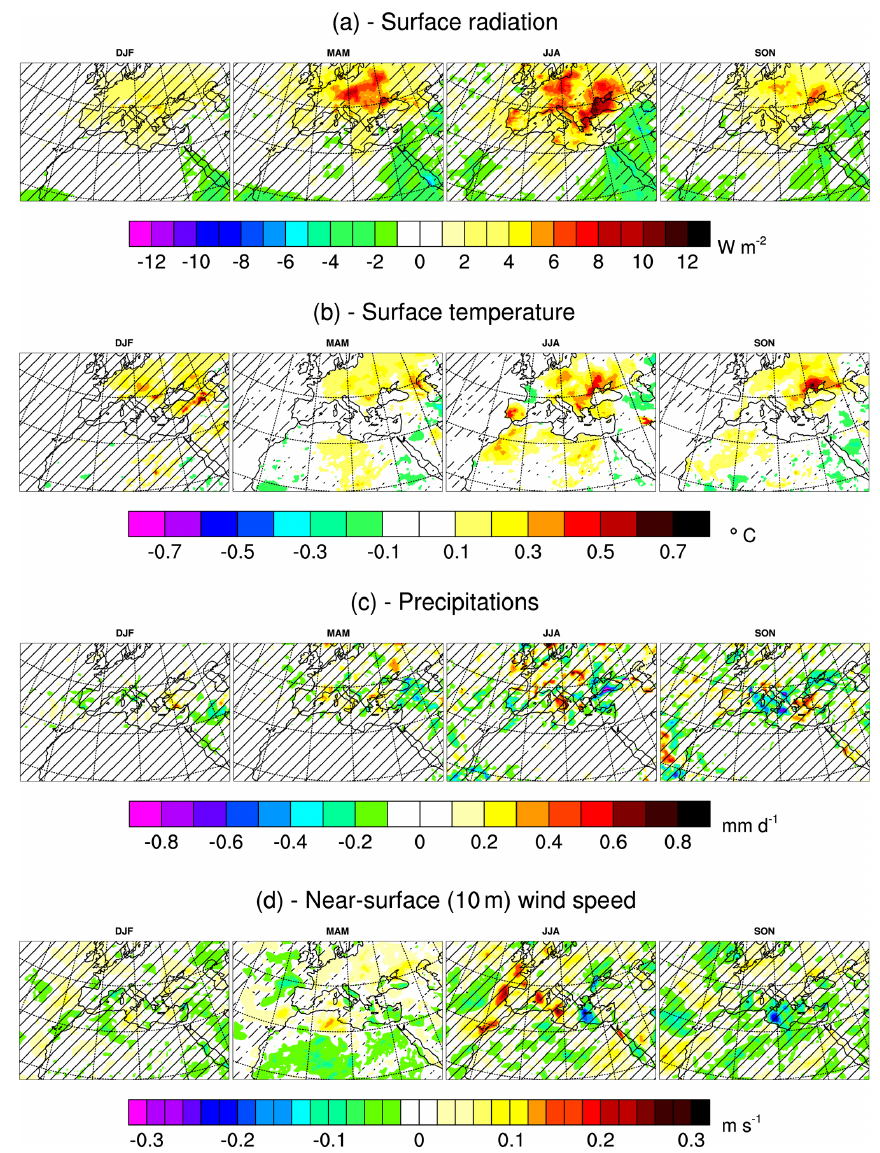
Figure 12. Anthropogenic aerosol role (difference between SSP585 and SSP585cst) in surface radiation (a) , surface temperature (b) , precipi- tation (c) and surface wind speed (d) changes between the periods 1971–2000 and 2021–2050. The hatched areas are statically non-significant with a threshold of